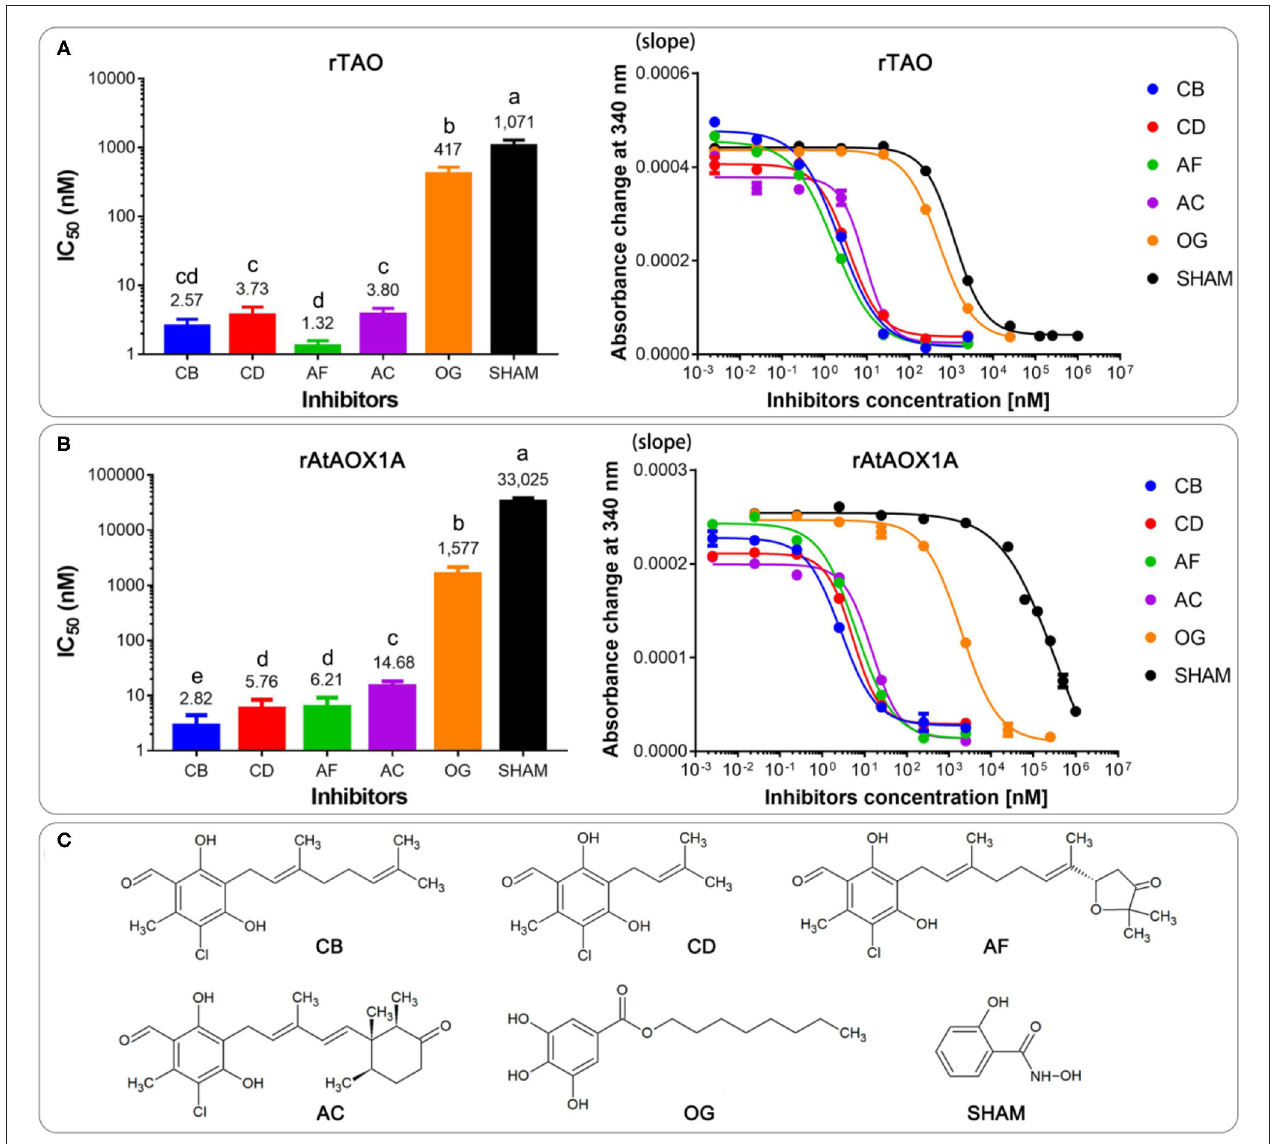
FIGURE 7 | Comparison of IC 50 values of the membrane-bound proteins of rTAO (A) and rAtAOX1A (B) with different inhibitors. (C) The chemical structures of inhibitors were used in this experiment. Data are mean ± SD of five replicates. For the IC 50 measurement, absorbance changes of NADH at 340nm with different inhibitors in a MOPS buffer (pH 7.5) were detected with 300 µ M NADH as the substrate. The significant difference p < 0.05 was marked as different